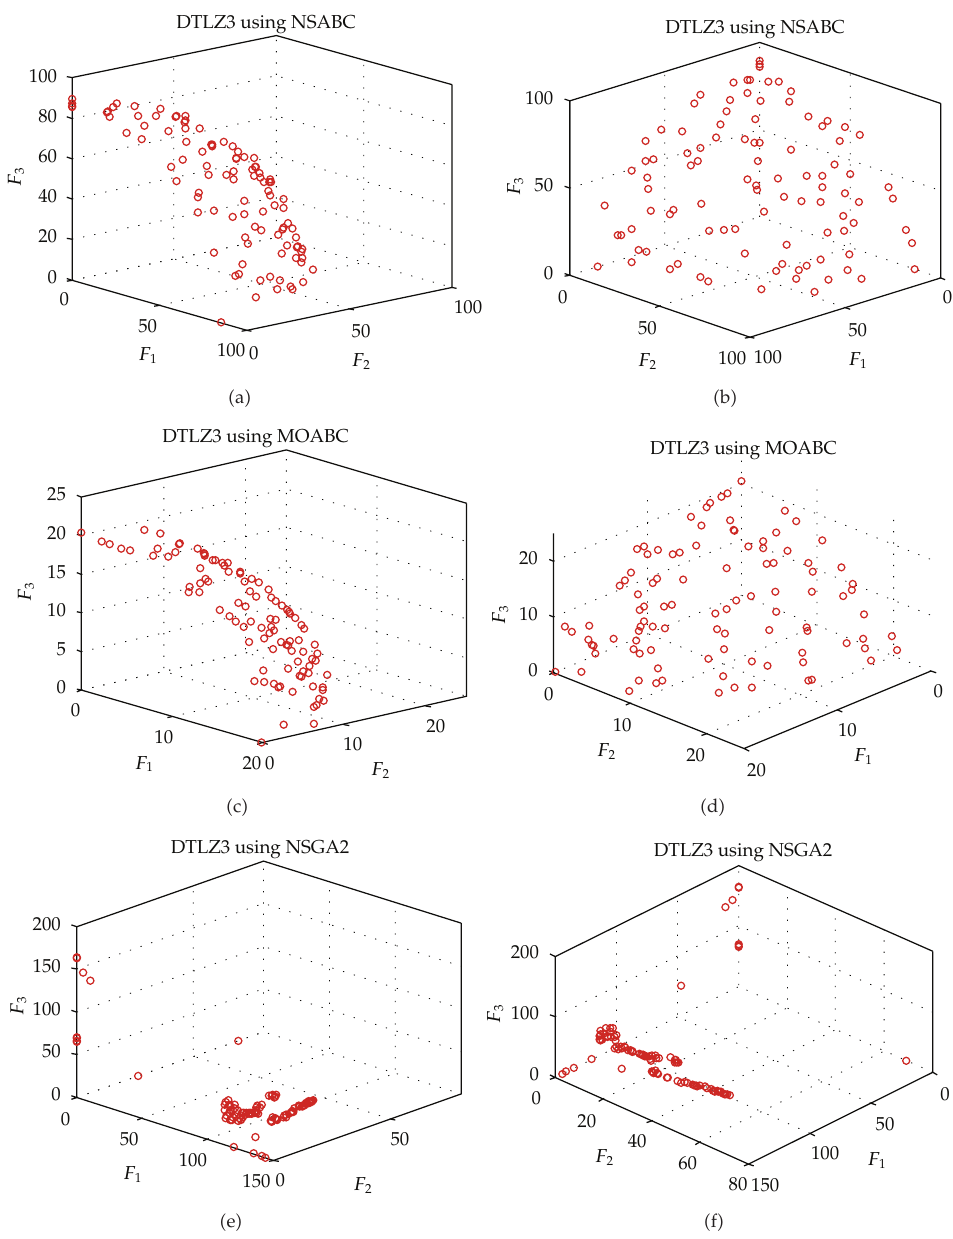
Figure 18: Pareto fronts obtained by NSABC, MOABC, and NSGA-II on DTLZ3 after 20000 FEs.